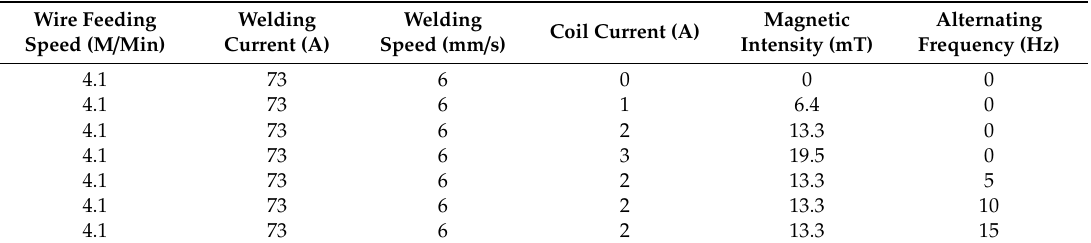
Figure 1. ( a ) Schematic diagram of the welding device; ( b ) detailed size of tensile test specimen. Table 2. Detailed experimental parameters.